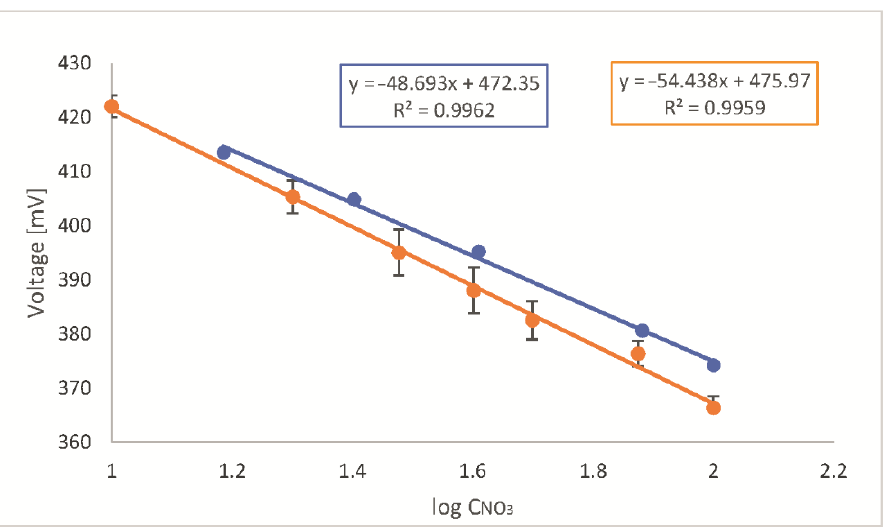
Figure 1. Examples of calibration graphs for NO 3 − ions determination obtained in presented flow system (blue color) and in traditional, batch condition (yellow color); x-axis: Logarithm of the concentration expressed as mg L −1 . Each point represents an average of at least three consecutive measurements.